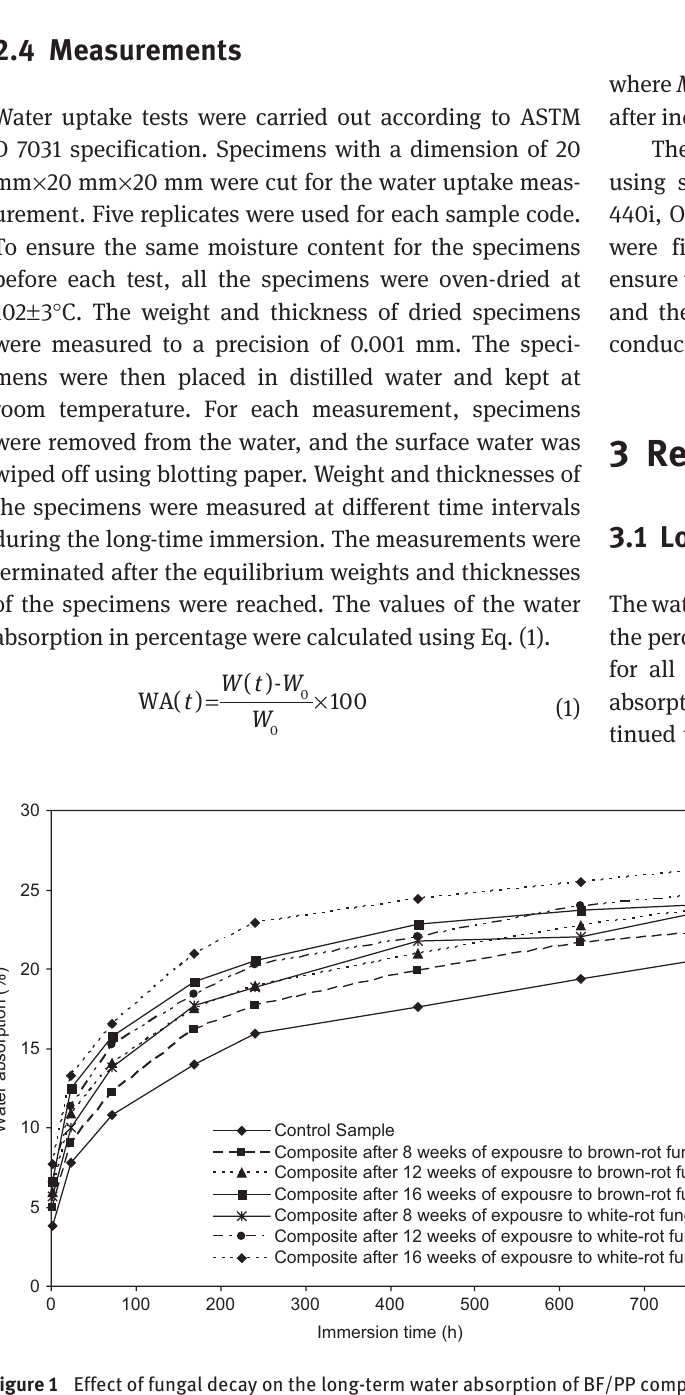
Figure 1 Effect of fungal decay on the long-term water absorption of BF/PP composites at different exposure